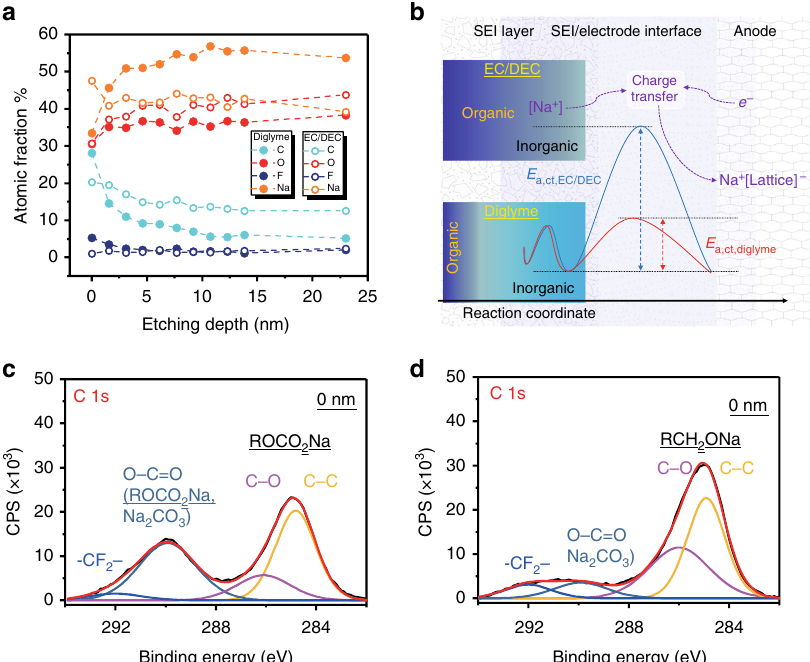
Fig. 5 SEI chemistry and the charge transfer process. a The atomic fractions of C, O, F, and Na as a function of SEI depth, calculated from the XPS spectra depth pro fi ling (Supplementary Figure 19). b Schematic of the SEI compositions formed in different electrolytes and a comparison of the charge transfer energy barriers. [Na + ] means that the Na + may be solvated. There is a smaller amount of organic species in the SEI formed in the diglyme-based electrolyte and the inner part of the SEI is mainly composed of inorganic species. c XPS C 1s spectrum before etching in the EC/DEC-based electrolyte. d XPS C 1s spectrum before etching in the diglyme-based